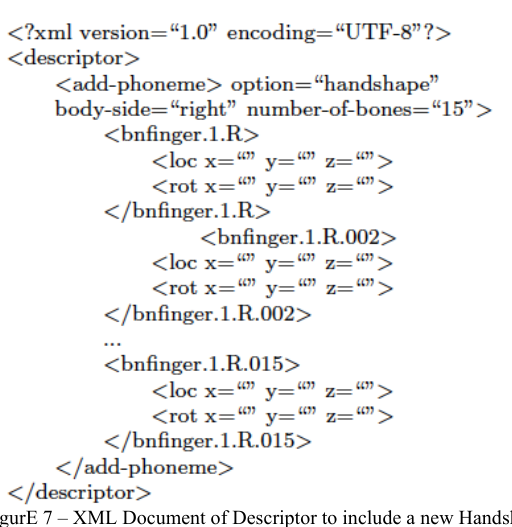
Figure 4 – XML Document of CORRECT sign